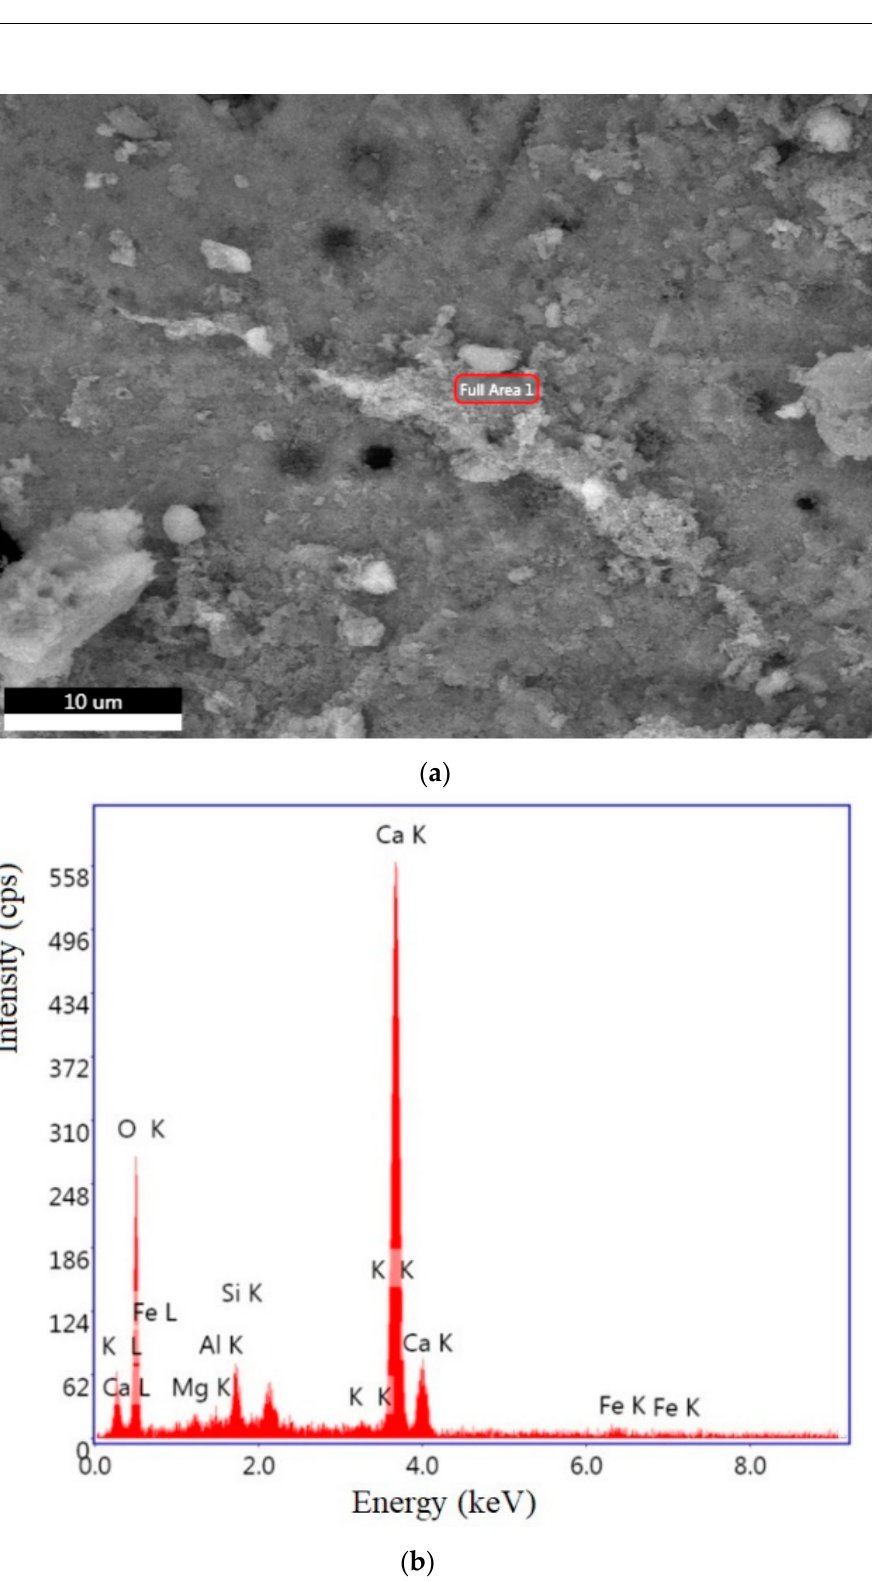
Figure 11. Scanning electron microscopy image ( a ) associated with EDX analysis ( b ) for sample C.